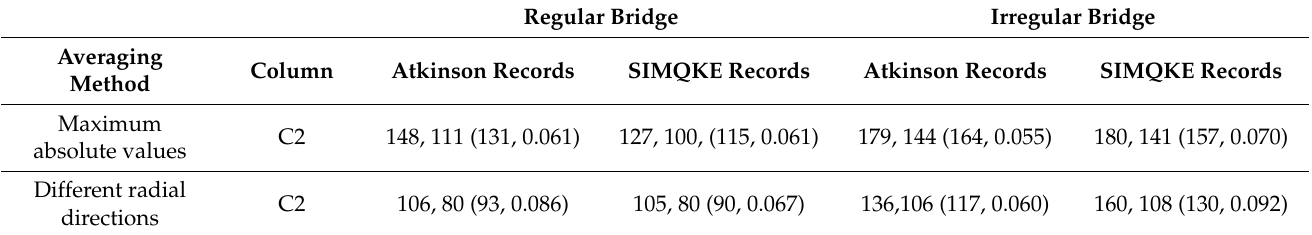
Table 4. Maximum and minimum of the predicted mean radial displacements (mm) using 3D analysis from 20 different subsets for the artificial records. Mean and coefficient of variation are given in brackets.